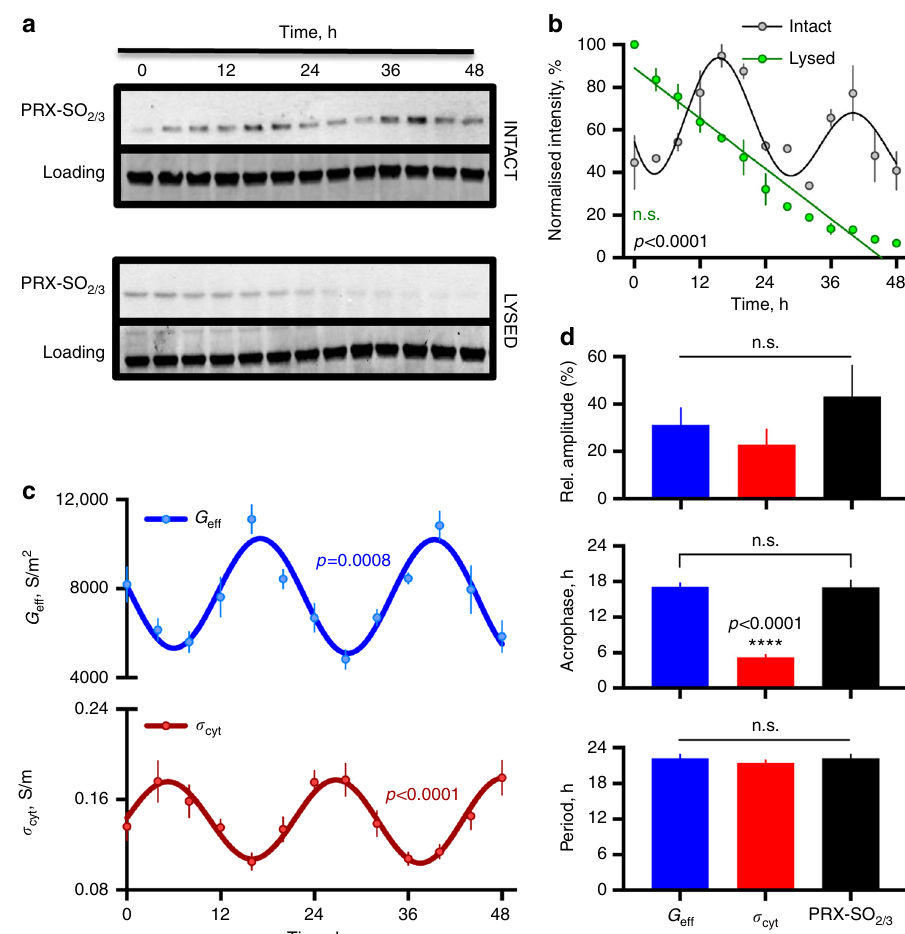
Fig. 2 Effective membrane conductance and over-oxidised peroxiredoxin levels peak during the anticipated cold phase. a In human RBCs, peroxiredoxin over-oxidation abundance rhythms peak during the anticipated cold phase following temperature cycles (as in Fig. 1c) and are abolished by RBC lysis. Representative blots are shown ( n = 3). b Western blot quanti fi cation of PRX-SO 2/3 levels in intact vs. lysed human RBCs (mean ± SEM, n = 3), p < 0.0001 for interaction effect by 2-way ANOVA ( n = 3, df = 12, F = 12.2). c Effective membrane conductance also peaks during the anticipated cold phase, in antiphase with cytoplasmic conductivity; mean ± SEM, n = 4. d No signi fi cant difference between the periods and relative amplitudes were detected between the two rhythmic DEP parameters and PRX-SO 2/3 (mean ± SEM, n = 4 and 3, respectively p = 0.59 by one-way ANOVA, df = 11, F = 0.55), whereas a signi fi cant difference in phase was detected (Holm – Sidak post-test). Rhythmicity and parameters were determined by cosinor vs. straight line fi t ( R 2 > 0.6, p value of fi t comparison reported in each case for b and c